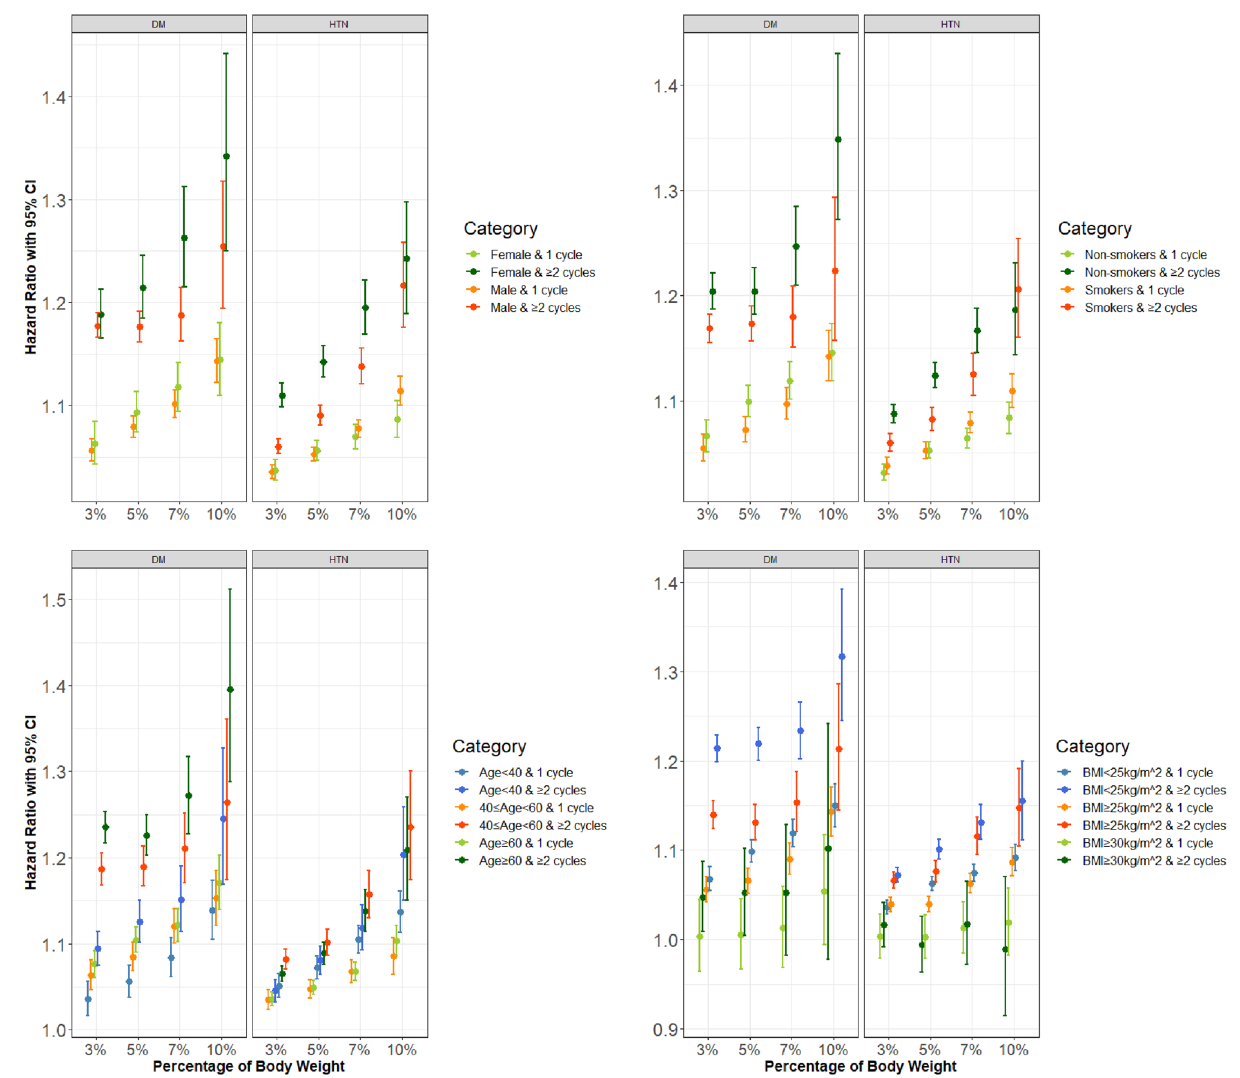
Figure 2. The association between body weight cycling and the risk of type 2 diabetes and hypertension according to sex, smoking status, baseline age, and obesity. Incident diabetes was defined as the prescription of antidiabetic medication or fasting blood sugar ≥ 126 mg/dL. Hypertension was defined as the prescription of hypertensive medication or systolic or diastolic blood pressure ≥ 140/90 mmHg. The hazard ratio was calculated with a Cox proportional hazards regression for different subgroups including sex (top left, a ), smoking status (top right, b ), age group (bottom left, c ), and body mass index (bottom right, d ) after adjusting for systolic blood pressure, fasting blood sugar, total cholesterol, smoking status, alcohol consumption, physical activity, past medical history, and family history. Dots and error bars indicate the hazard ratio and 95% confidence interval,